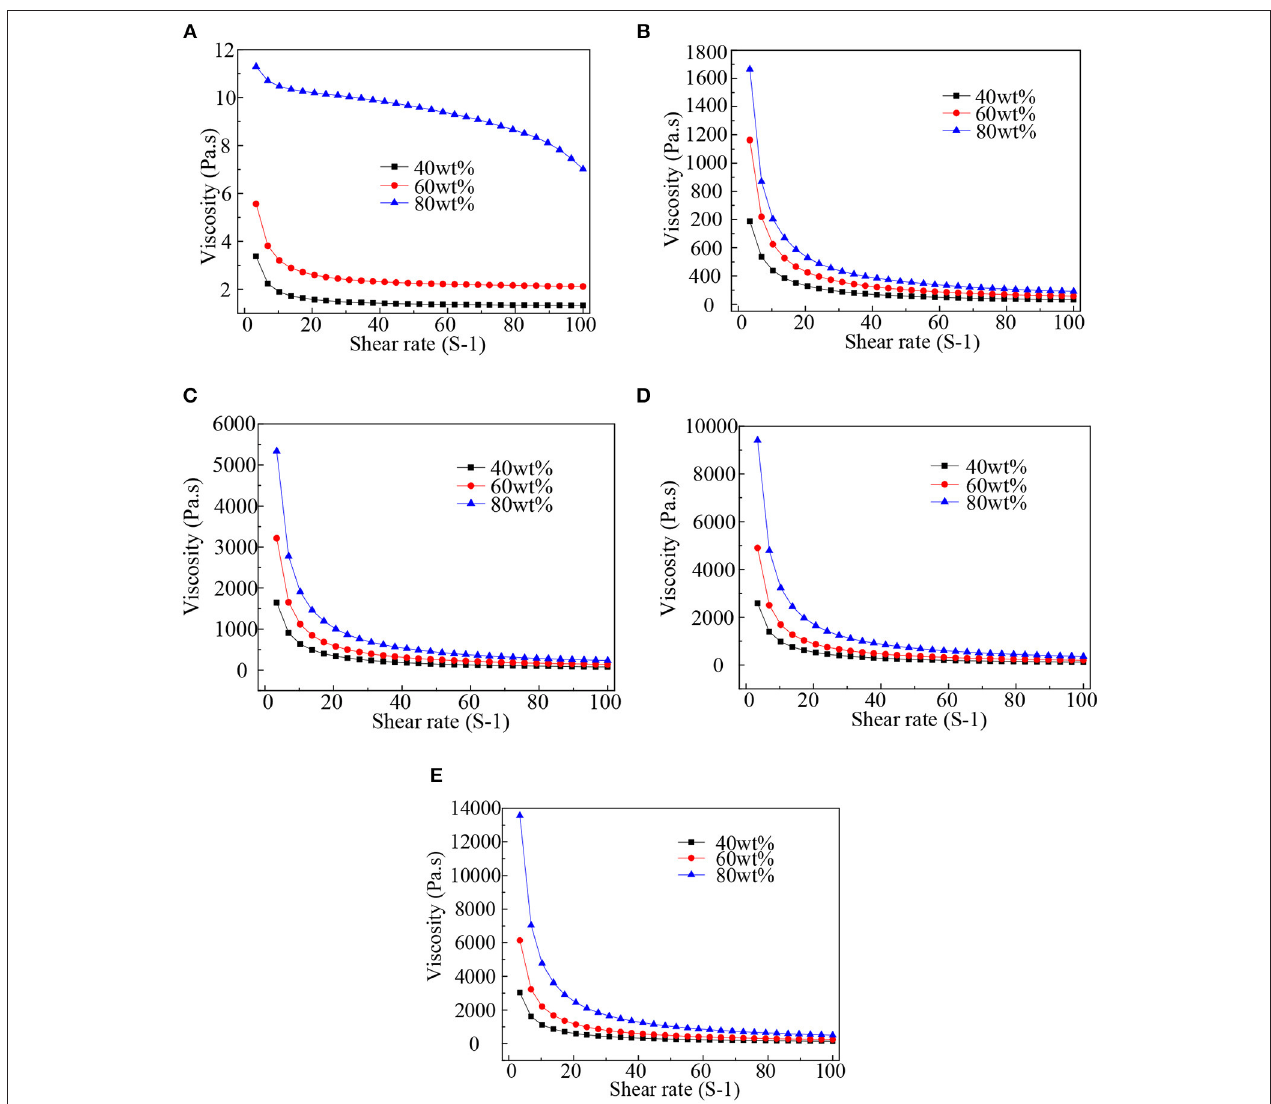
FIGURE 5 | Viscosity vs. shear rate under different magnetic flux densities ( A : B = 0 mT; B : B = 240 mT; C : B = 480 mT; D : B = 720 mT; E : B = 960